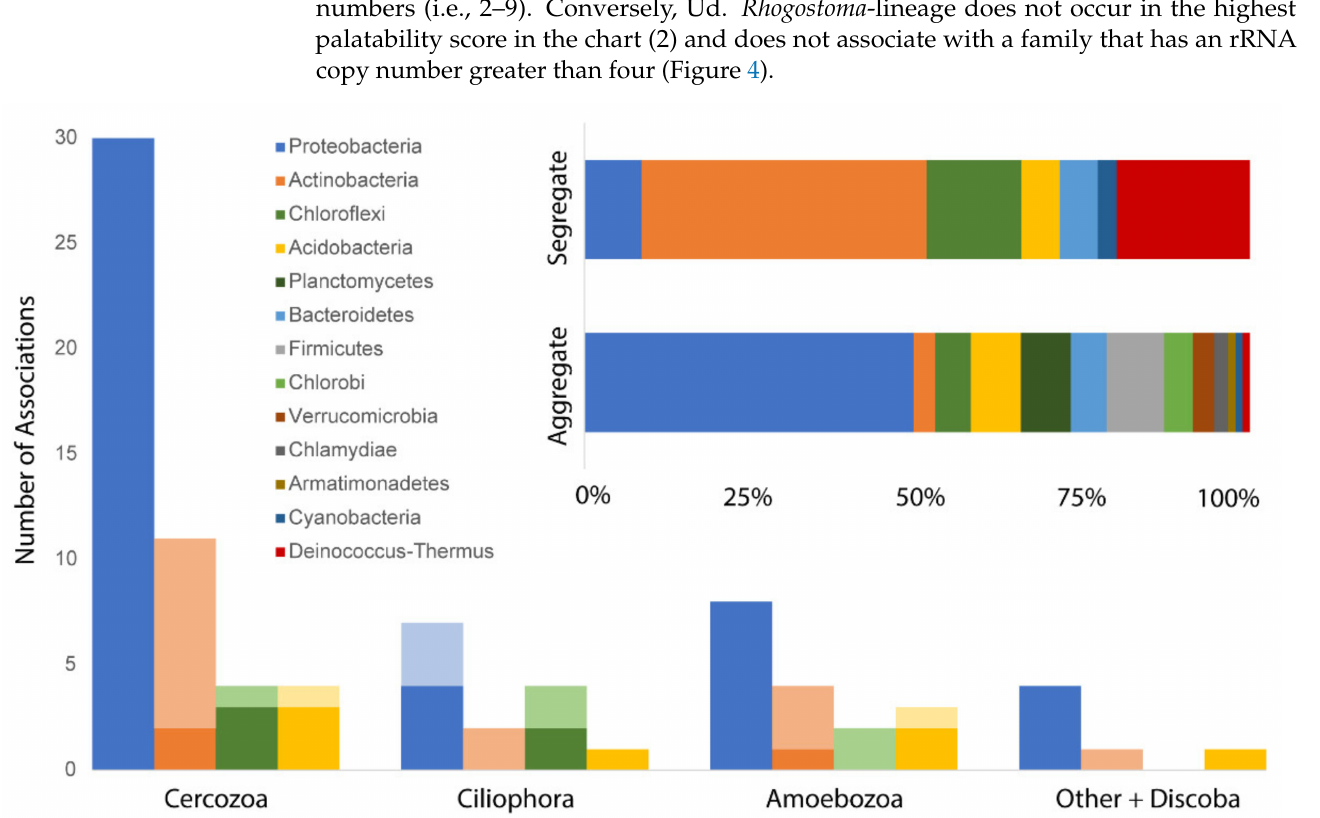
Figure 3. Phagotrophic protists aggregate with Proteobacteria and segregate from Actinobacteria. Bacteria are color-coded by phylum but summed along the y -axis as numbers of families (1:1 ratio to associations) per phylum. Bar charts (inset) show proportion of bacterial phyla that aggregate or segregate with all phagotrophic protist response groups combined. Stacked bar graphs ( x -axis) show proportion of bacterial phyla per phagotrophic protist response group (e.g., Cercozoa). Darker shades ( x -axis) indicate aggregate associations and lighter shades indicate segregate